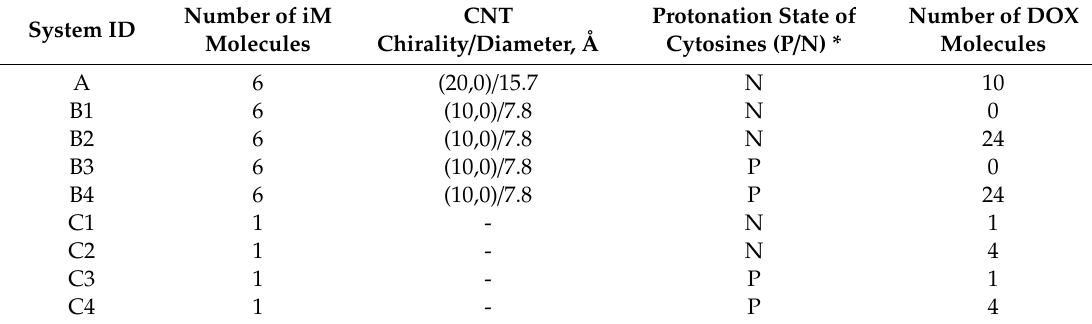
Table 1. Definitions of the analyzed systems.